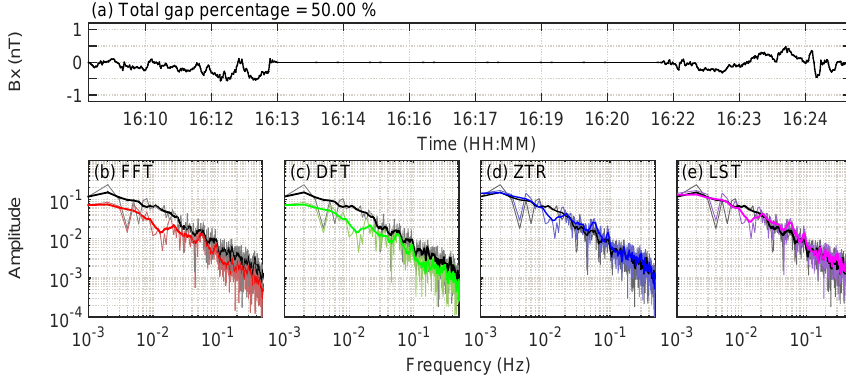
Figure 13. Case study for the SLG test applied to the VEX data set. The format is similar to Fig. 3. In addition, panels (b) – (e) also show the original FFT spectrum (black) and the average spectra for each method (thick lines).